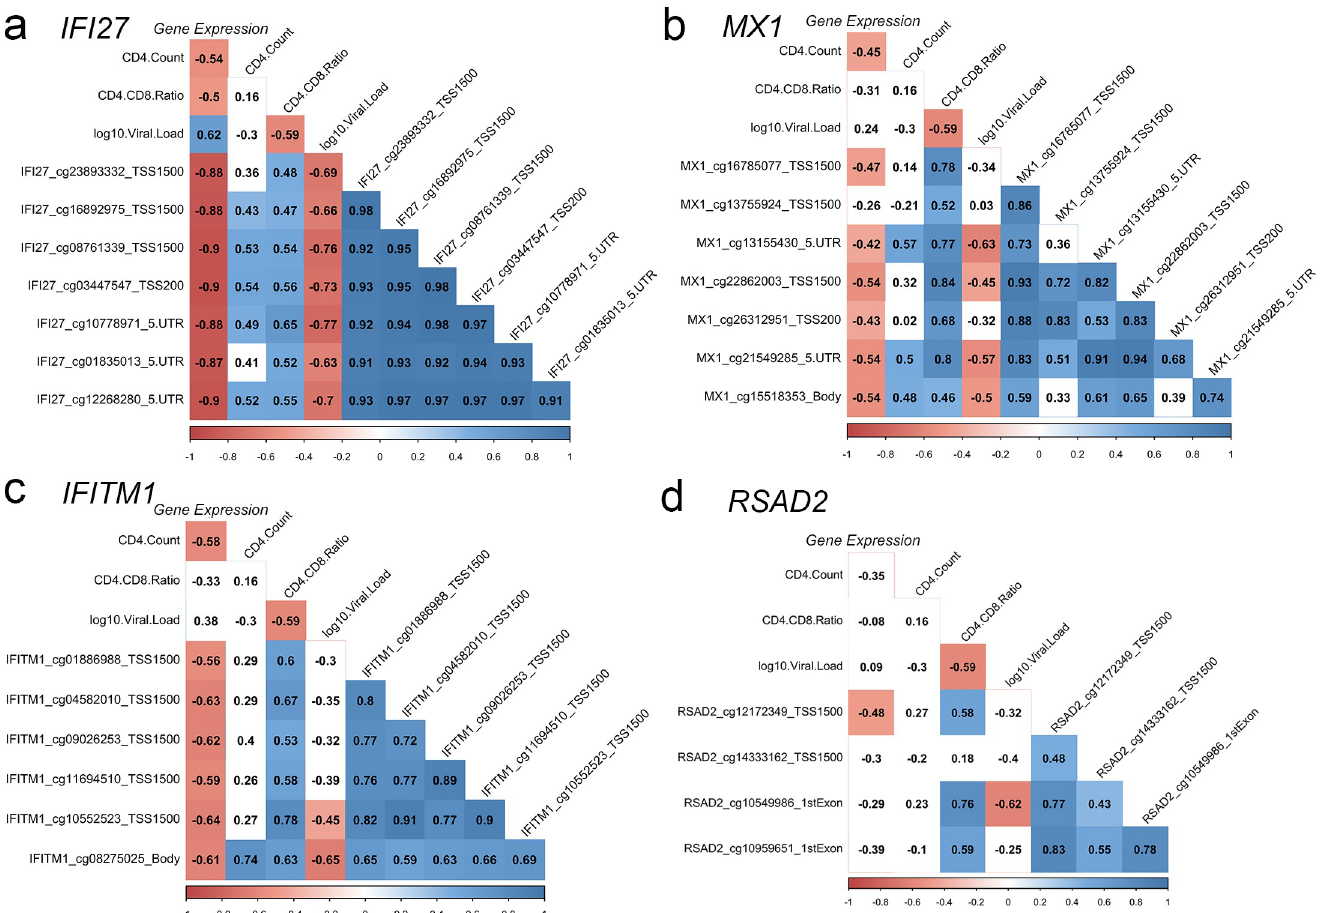
Fig 7. Monocyte gene expression associates with DNA methylation levels and clinical parameters during acute HIV infection. (a-d) Correlation matrix plots showing the correlation coefficient for associations between gene expression levels, CD4 count, CD4/CD8 ratio, viral load, and DNA methylation levels at specific genomic loci. Significant correlations displayed as solid colored boxes (red displayed for negative correlations and blue for positive correlations). Correlation coefficient displayed.